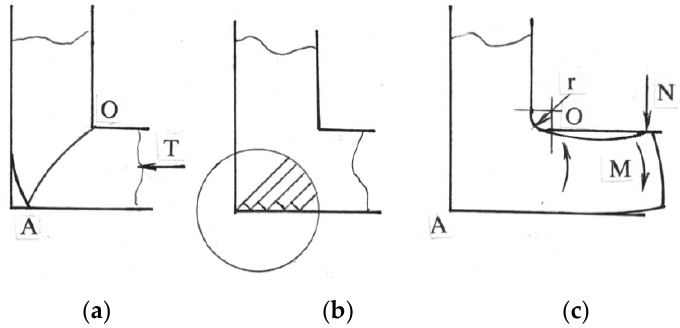
Figure 4. ECAE with forming “gap” ( a ), small-scale localization ( b ), and re-bending in the outlet channel ( c